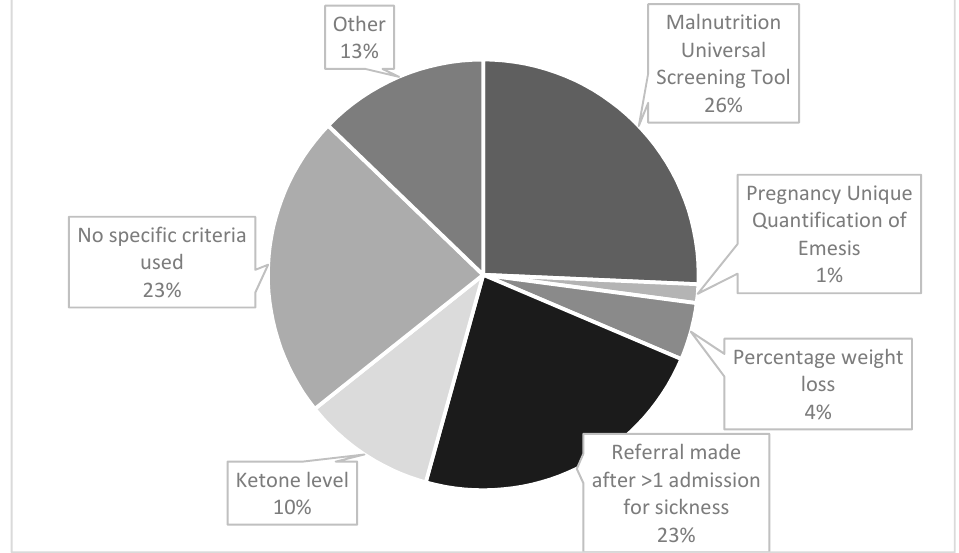
Figure 1. Clinical criteria used to refer a patient with HG for dietetic input.